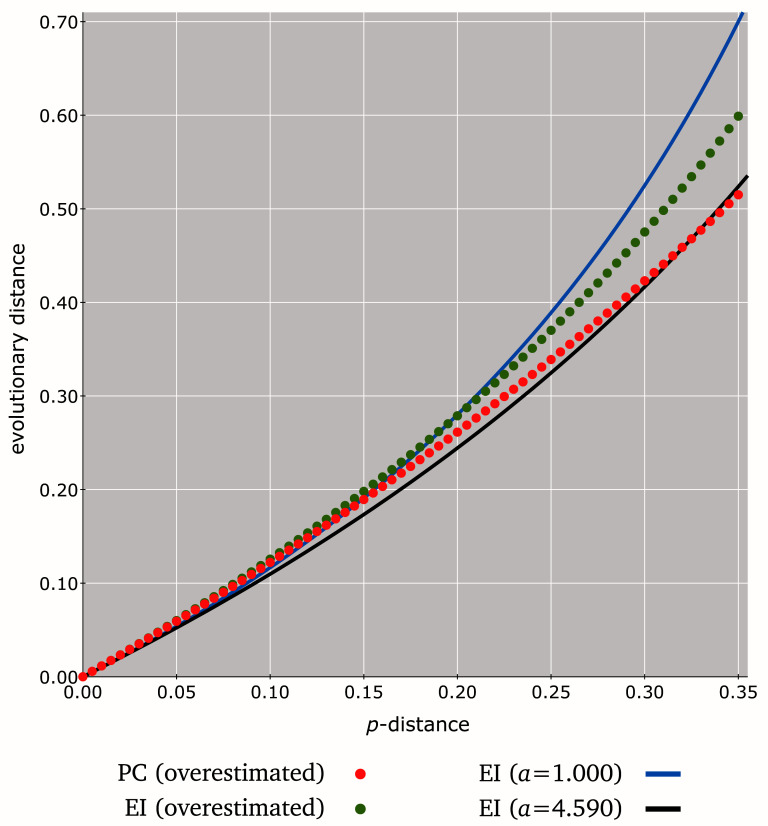
Impact of the MH
p-distance upward bias on PC and EI transformations.The relationship between the
p-distance
p (
x-axis ranging from 0.00 to 0.35) and the corresponding evolutionary distance
d (
y-axis ranging from 0.00 to 0.70) is represented when using PC (red dots) and EI (with equilibrium frequencies
f
2; green dots) transformations
(2) on
p^ =
β p with
β = 1.15. For ease of comparison with
Figure 3, EI (
f
2) transformation
(3) on
p are represented with
a = 1.000 (blue curve) and
a = 4.590 (black curve).